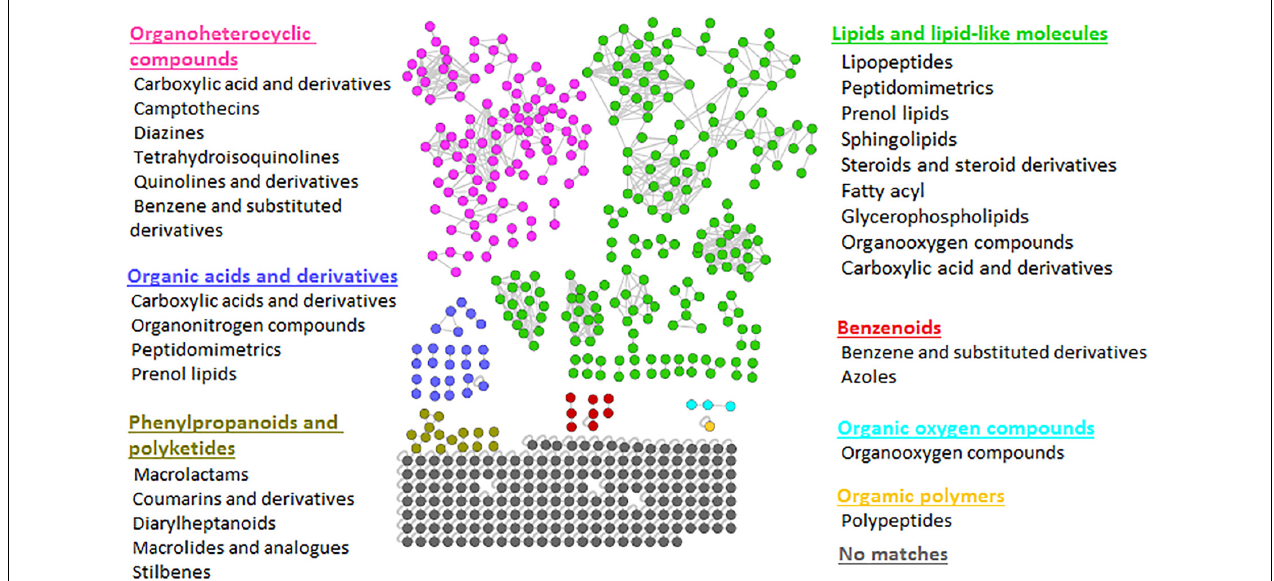
FIGURE 2 | Representative MolNetEnhancer mass spectral feature-based network of consortium showing the chemical superclasses (written in colors corresponding to the nodes) and classes (written in black) that were putatively annotated based GNPS library matches and enhanced with substructure annotations (MS2LDA), network annotation propagation (NAP), and DEREPLICATOR outputs. The MolNetEnhancer networks of Bacillus isolates are shown in Supplementary Figures 4, 5 .